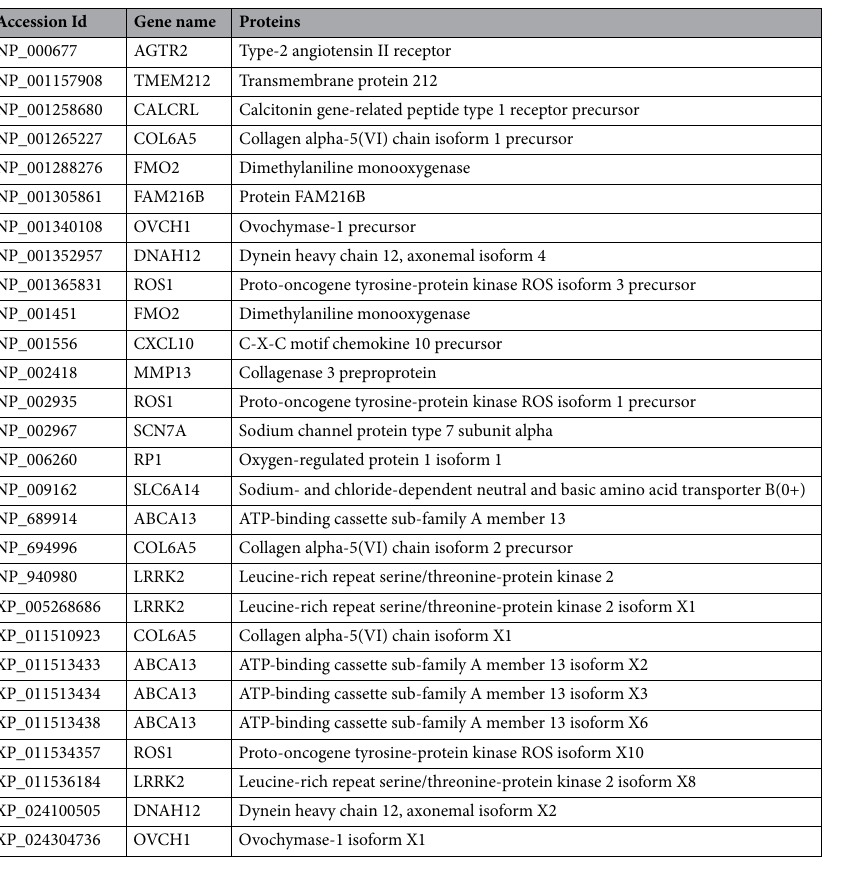
Table 1. Human genes shared among the clusters of the three coronaviruses SARS-CoV-2, SARS and